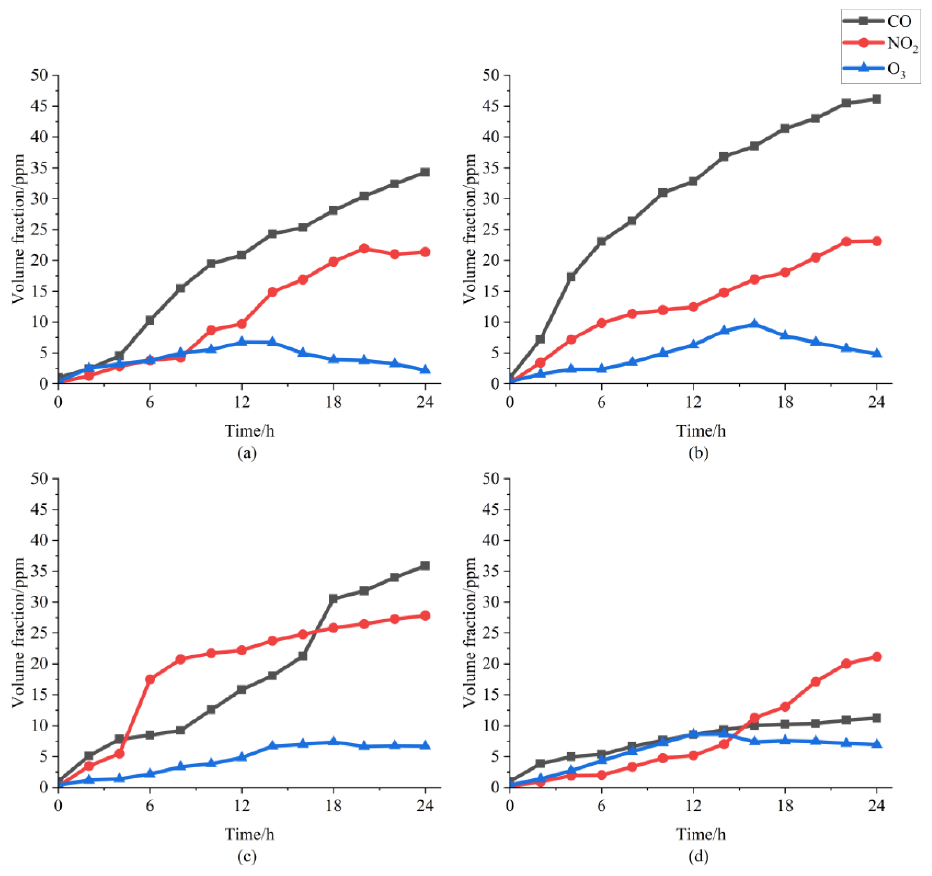
Figure 3. The volume fraction of characteristic gases over time: ( a ) metal protrusion, ( b ) air gap between the metal conductor and the insulator, ( c ) pollution on the insulator surface, and ( d ) charged metal